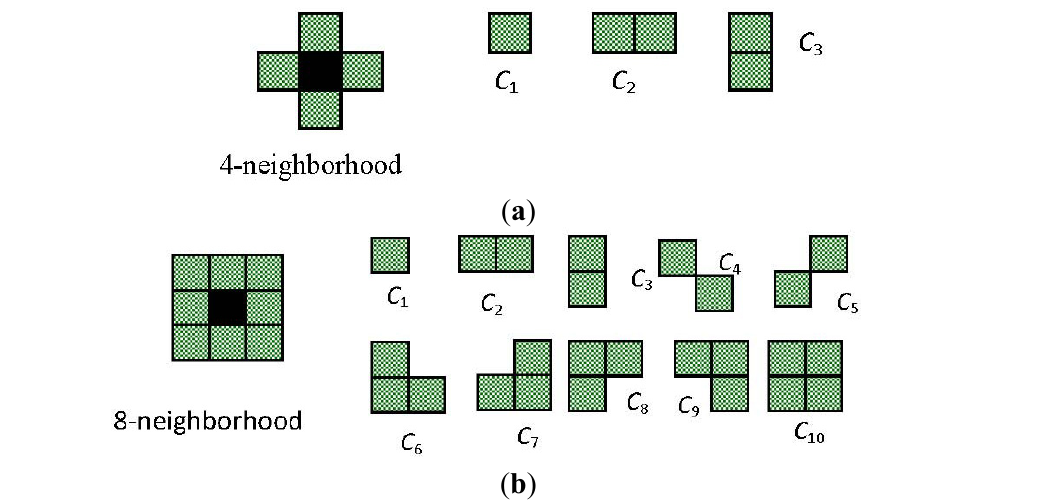
Figure 1. Clique types for ( a ) four-neighborhood; ( b )